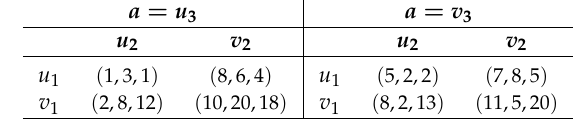
Table 6. The utility matrix of Example 3 for the basic game G 2 for a ∈ A 3 .